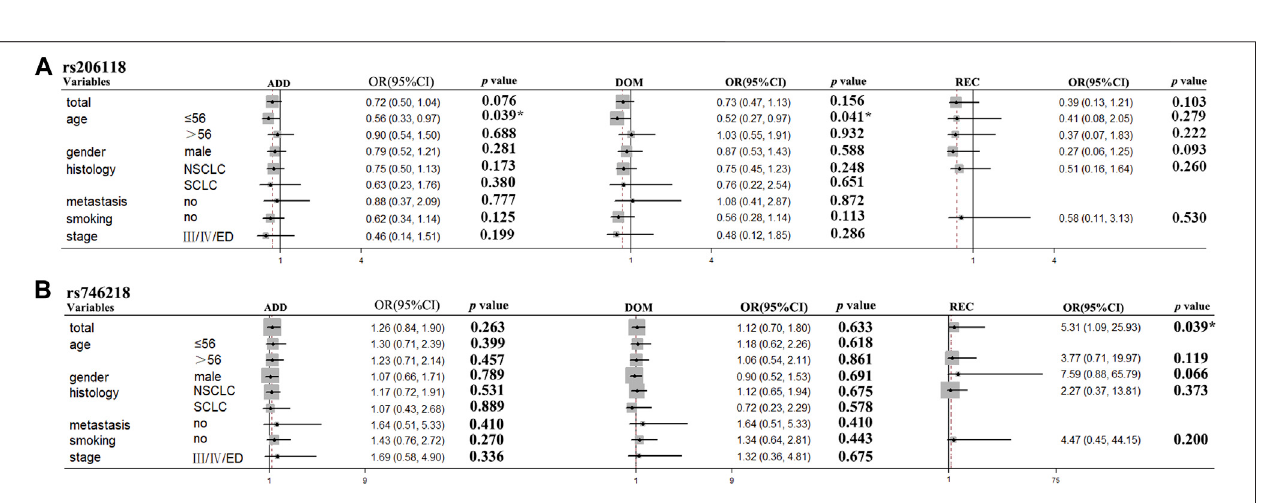
Additive model: comparison between minor allele subjects and major allele subjects. Dominant model: comparison between minor allele carriers and major homozygous subjects. Recessivemodel:comparisonbetweenmajorallelecarriersandminorhomozygoussubjects.OR,oddsratio;CI,con fi denceinterval; p , p -valueforbinarylogisticregressionanalysis;Ref., reference. * p < 0.05.